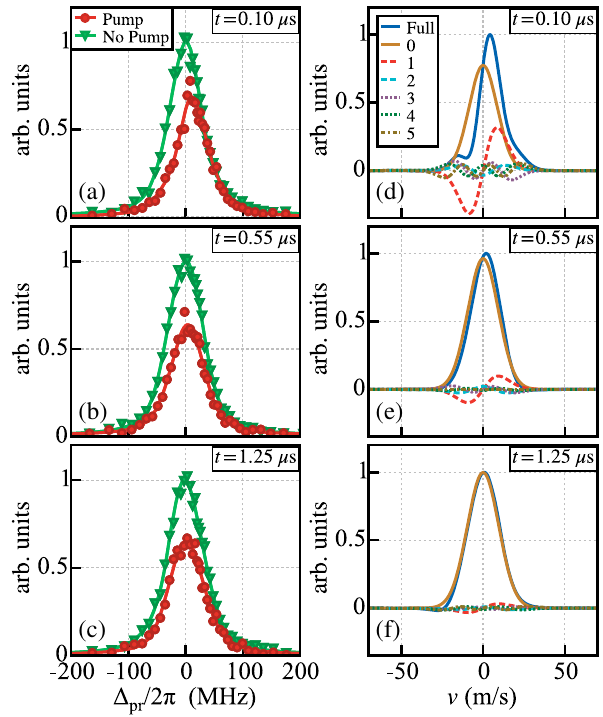
FIG. 2. (a) – (c) Time evolution of 2 S 1 = 2 − 2 P 1 = 2 LIF spectra, pumped (red circles) and unpumped (green squares), for spin ¯ Γ 3 . 0 . (Bars denote þ 1 = 2 ions in a plasma with ¯ κ ¼ 0 . 55 and i ¼ time-averaged values; see Appendix B.) Spectra are fit (red and green lines) to a fifth-order Hermite-Gauss expansion of the velocity distribution convolved with the Lorentzian contribution from the laser and natural linewidths. (d) – (f) Full velocity distributions determined from the fits of pumped data to Eqs. (3) and (4), along with constituent Hermite terms n ¼ 0 – 5 . Most of the velocity distribution is contained in the first few terms. Terms of order larger than zero decay in time as the distribution relaxes to a